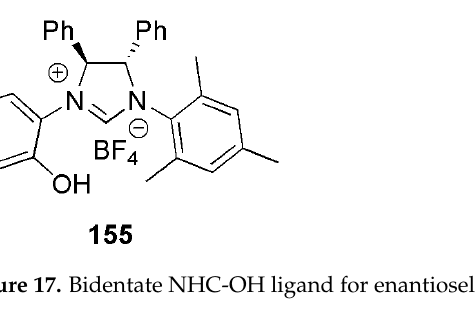
Figure 17. Bidentate NHC ‐ OH ligand for enantioselective allylic alkylation [98].